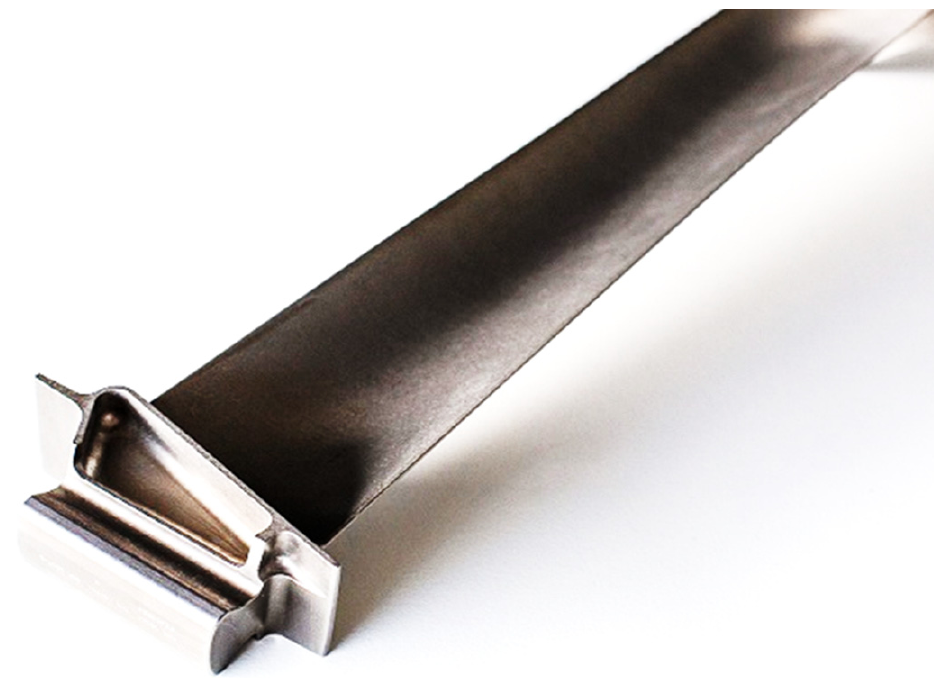
Figure 9. Turbine blade fabricated using the EBM technique [88].